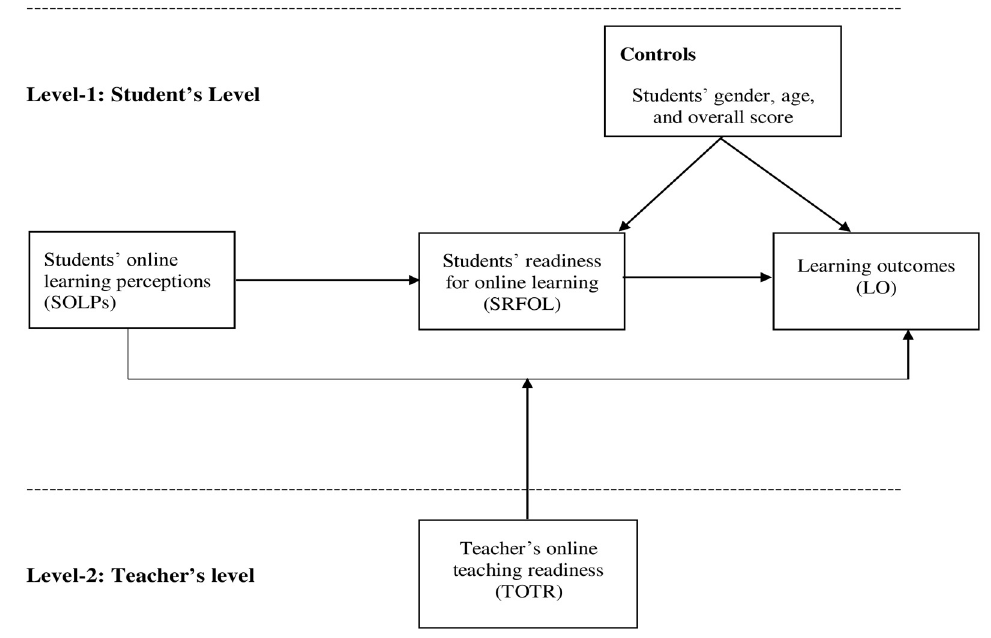
Figure 1. Conceptual framework.